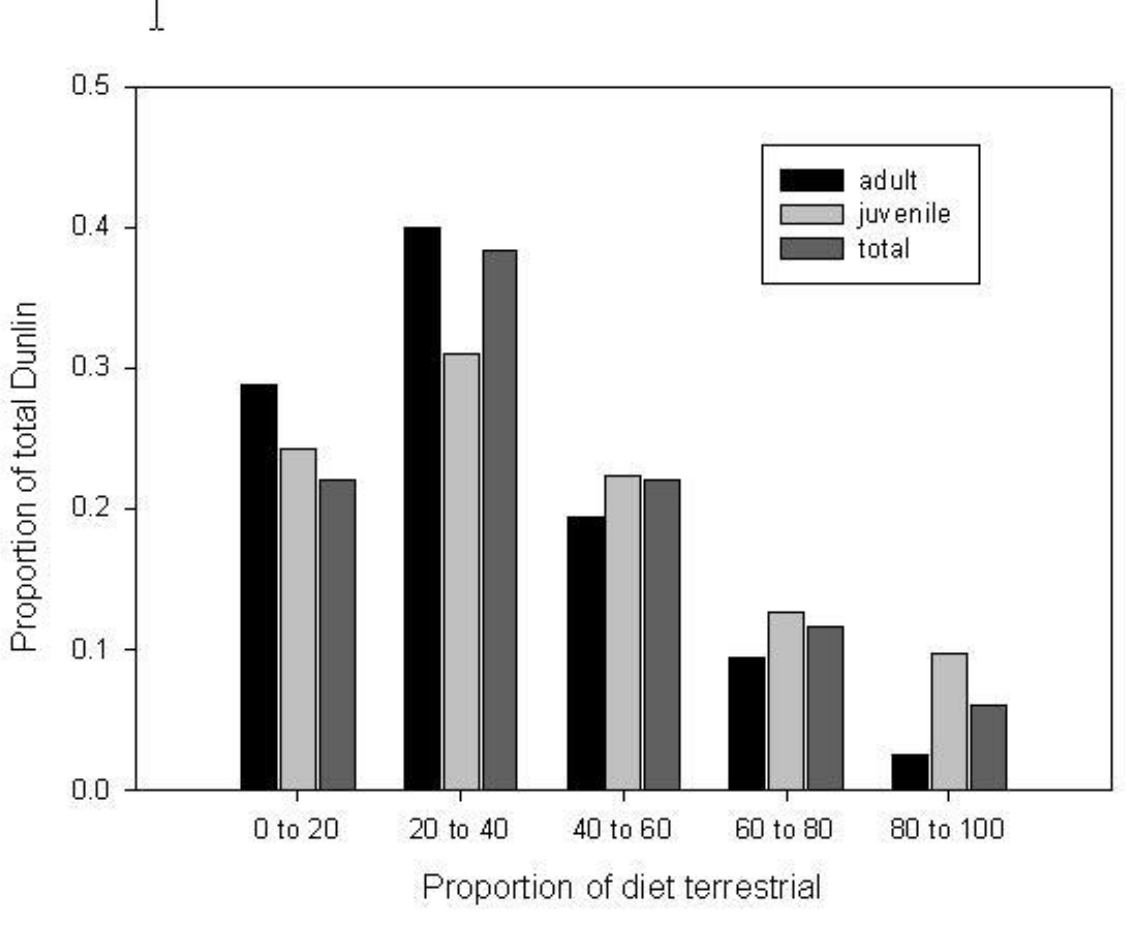
Fig. 4 . Frequency distribution of percentage of diet derived from fields for all Dunlin (1997–2000) and by age class (1998–2000). Frequencies represent the proportion of individuals from within that age class. Proportion of diet terrestrial based on two-isotope model